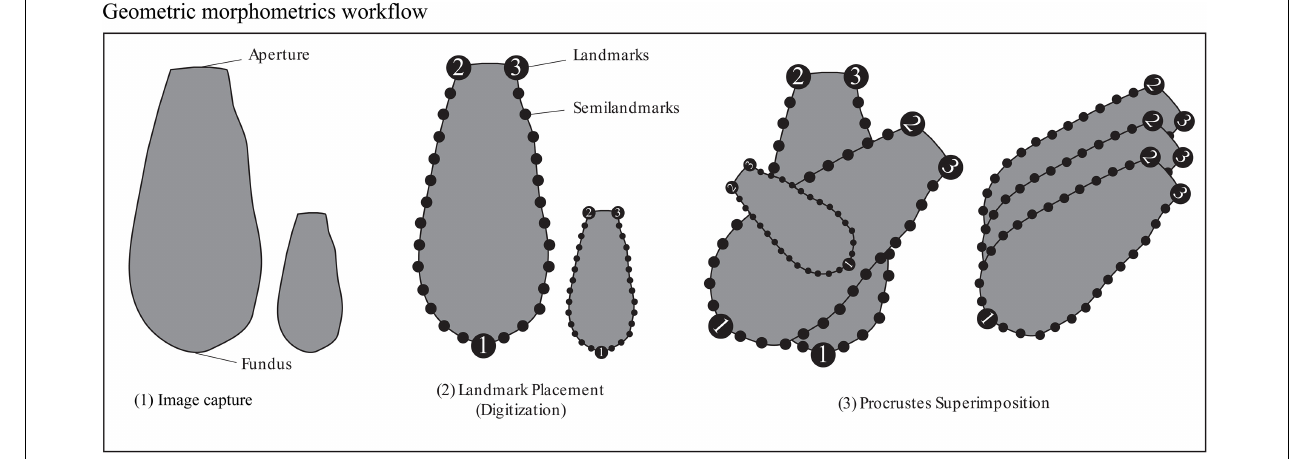
FIGURE 2 | Figure illustrating placement of landmarks and semilandmarks for the geometric morphometric analyses Procrustes-PCA and Aperture-PCA. The line drawings are not to